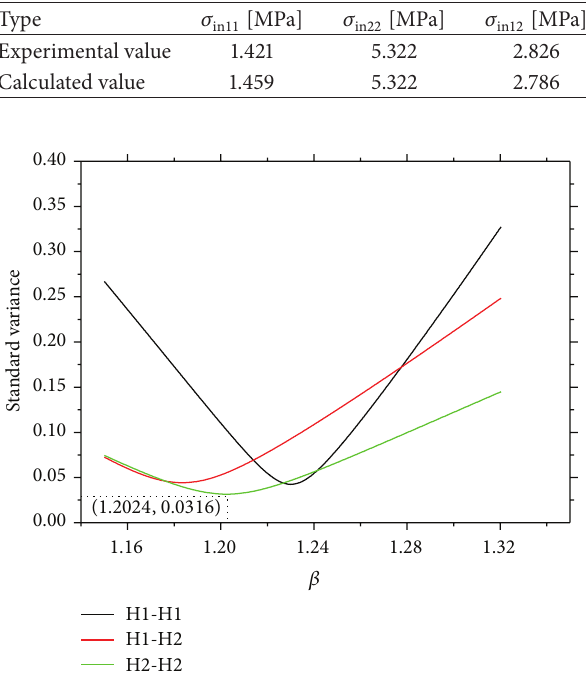
Figure 9: Standard variation of the inserting stress into structural coefficient 𝛽 in three